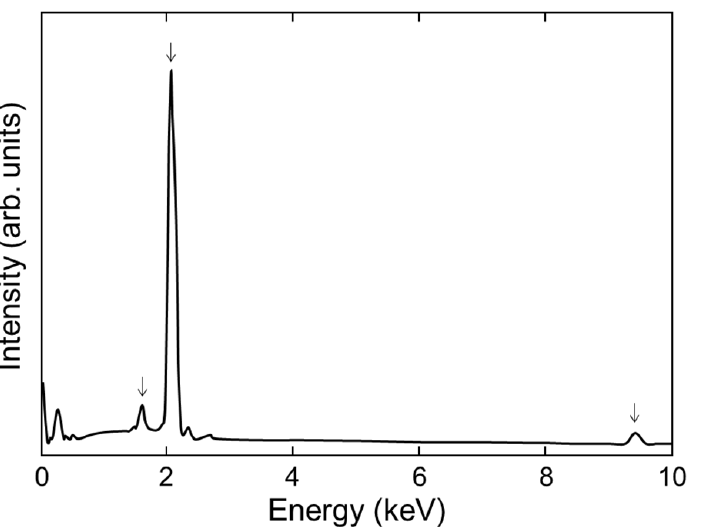
Figure 7. EDX spectrum of the obtained platinum cones. The arrows indicate the platinum signals observed at 9.42 keV (L α line), 2.04 keV (M α + M β line) and 1.59 keV (M ξ line). The platinum cones were further analyzed using TEM. Figure 8 shows a TEM image of the tip area of the cones shown in Figure 6b. The radius of curvature of the tip was 13 nm. The selected-area electron diffraction pattern in the inset of Figure 8 exhibits